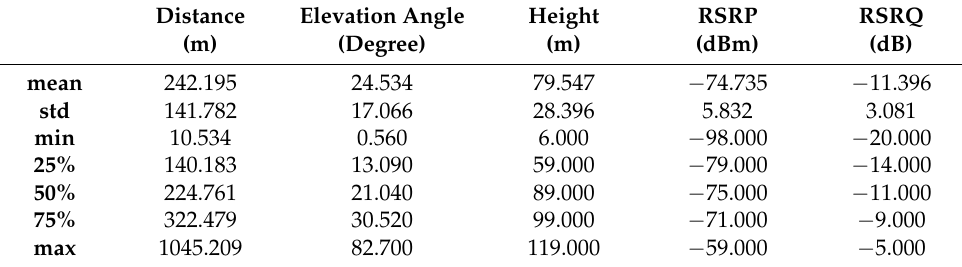
Table 4. Summary statistics of considered